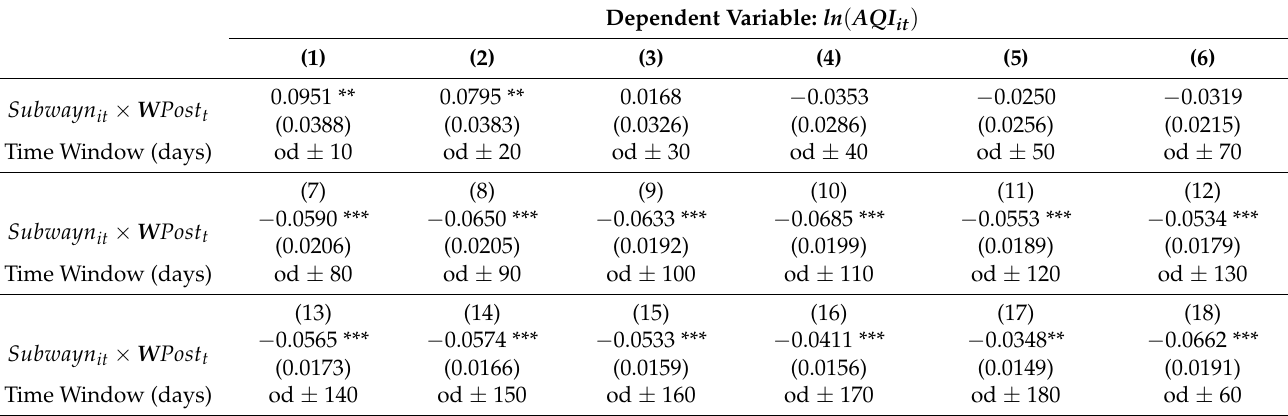
Table 5. DID with varying time